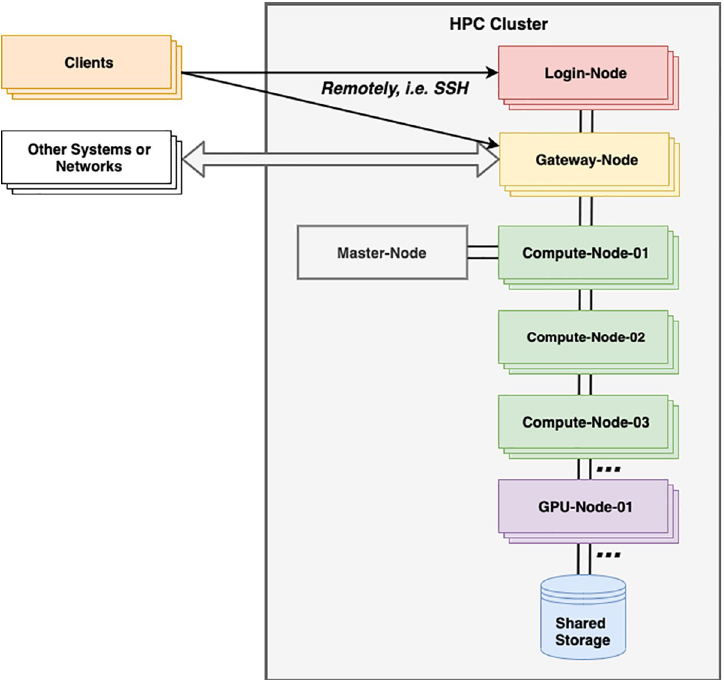
Fig 1. Simplified organisation of a typical HPC system. Users log in remotely via SSH to a login node from a client machine. Jobs are scheduled by job scheduler software running on the master node and run on compute nodes and GPU nodes. Gateway node(s) facilitate the transfer of large files into and out of the HPC system. G AU : AbbreviationlistshavebeencompiledforthoseusedthroughoutFigs 1 and 2 : Pleaseverifythatallentriesarecorrect : PU, graphics processing unit; HPC, high-performance computing; S AU : PleasedefineSSHintheabbreviationlistofFig 1 ifapplicable = appropriate : SH, (Secure Shell Protocol).